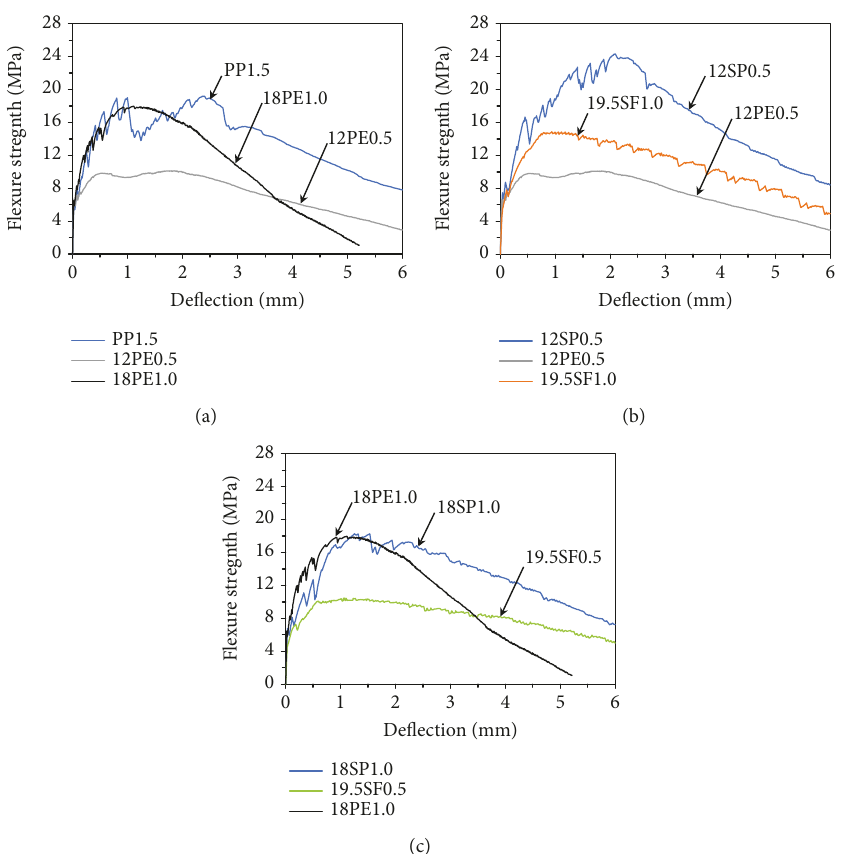
Figure 9: Average fl exural load-de fl ection behavior by various conditions of w/b of 17.2%: (a) U17.2 based on PE fi bers with di ff erent lengths, (b) U17.2 based on steel fi bers with short PE fi bers, and (c) U17.2 based on steel fi bers with long PE fi